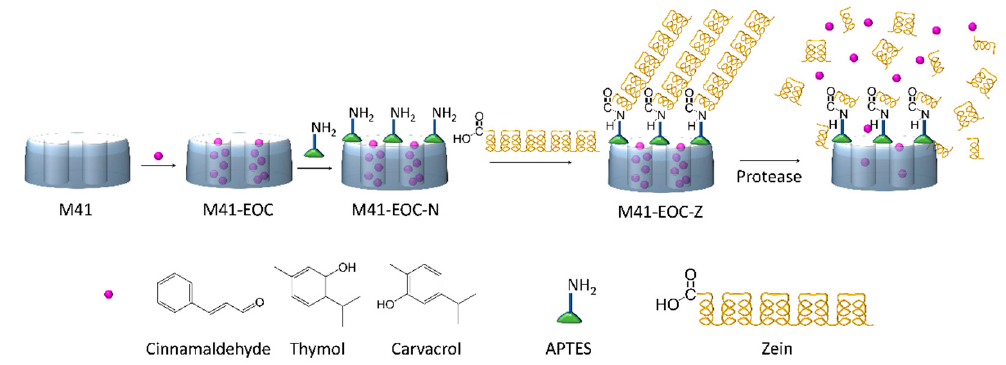
Scheme 1. Representation of M41–EOC–Z synthesis and cargo release. Cargo loading (EOCs) is followed by APTES-functionalization, and finally zein is attached to the amino groups. The cargo is actively released due to the hydrolyzing action of protease enzymes.